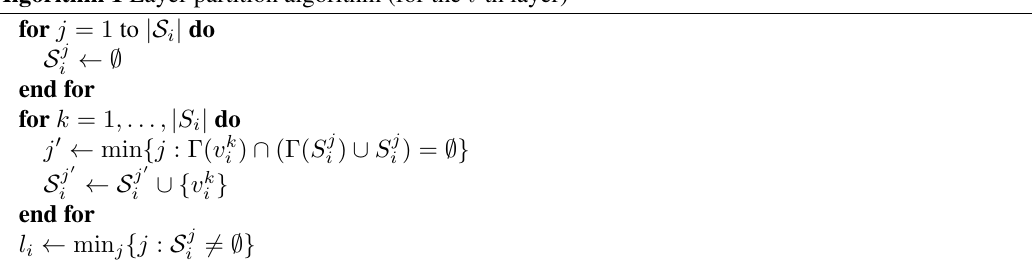
Algorithm 1 Layer partition algorithm (for the i -th layer)